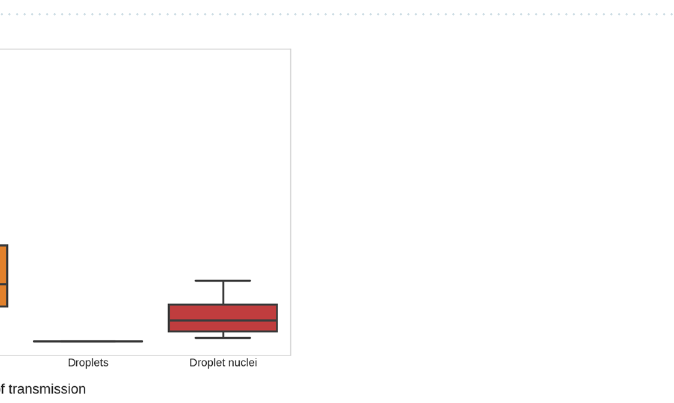
Figure 2. Model Prediction for the ( A ) Distribution of the serial index. Shaded area is the bounds of observed data 10,31–33 ( B ) The cumulative SAR over time.